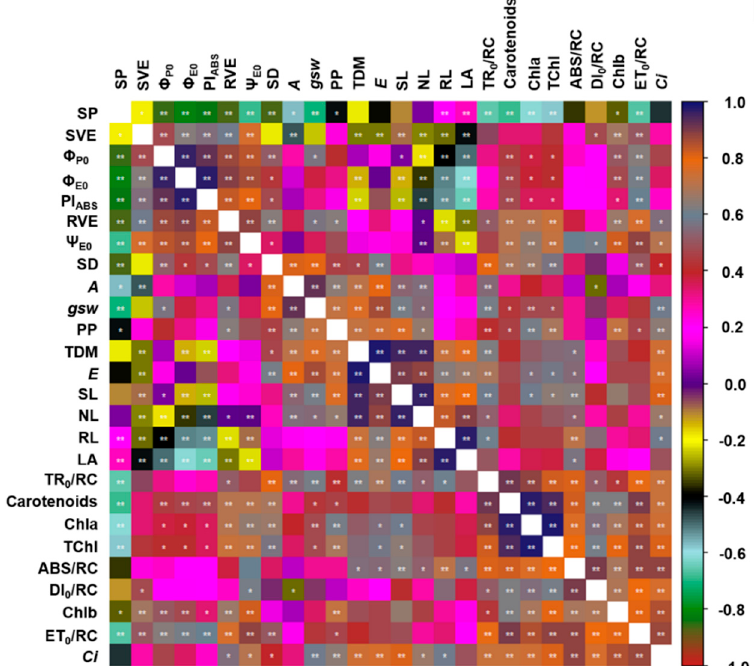
Figure 11. Correlation between the anatomical variables, photosynthetic pigments, chlorophyll a fluorescence parameters, gas exchange, and growth of the seedlings of Hymenaea courbaril L. cultivated in a hydroponic system and sampled at 30-day intervals across their initial development (30, 60, 90, 120, 150, and 180 days after transplantation). * significant at a probability of 5%; ** significant at a probability of 1%.